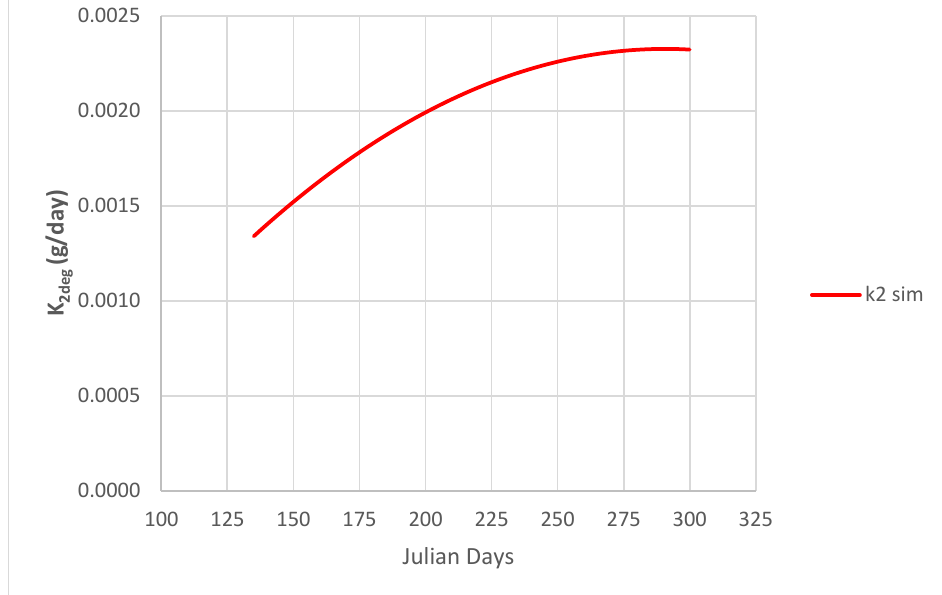
Figure 6. Values of k 2deg ( t ) interpolated by the Equation (11). The curve k 2deg ( t ) was taken from Vitale et al. (Adapted with permission from Vitale et al. [40]. Copyright 2014, copyright iForest– Biogeoscience and Forestry) -after conversion in (g/day), since the initial rate of lignin degradation was not recorded for this study.